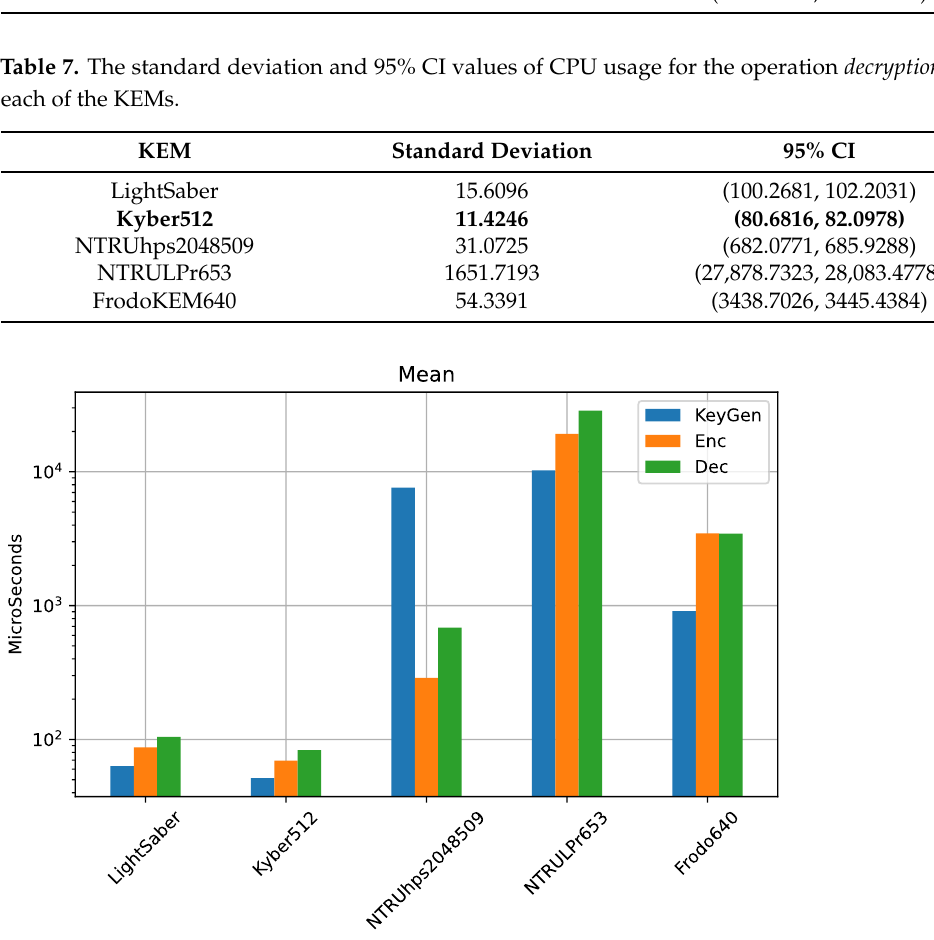
Figure 6. Mean usage of the CPU for each operation of each cipher. Visually, the performance of the KEMs LightSaber and Kyber51 is very similar. NTRUhps2048509 is the next in performance, followed by NTRULPr653, and then FrodoKEM640. Tables 5–7 show the standard deviation and 95% CI for key generation , encryption , and decryption ,